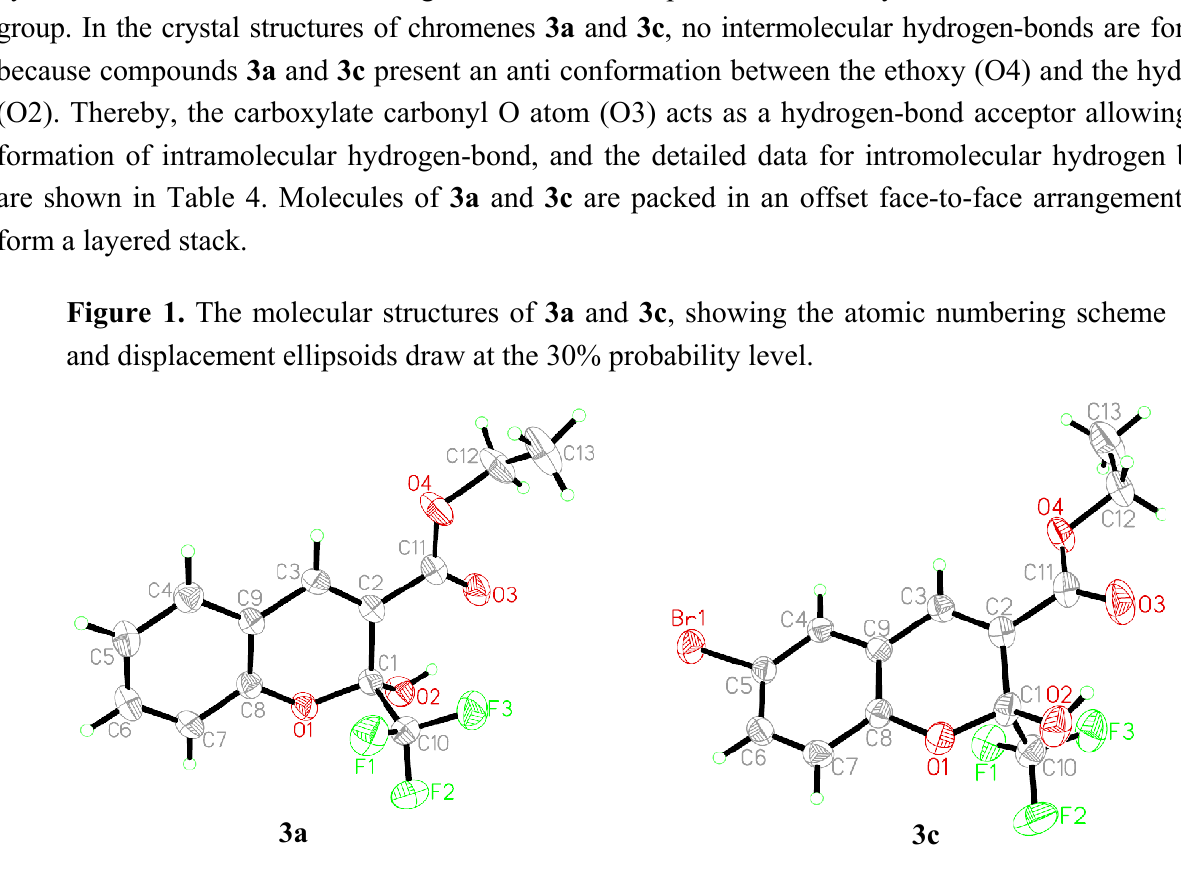
Figure 2. View of the molecular packing in 3a and 3c